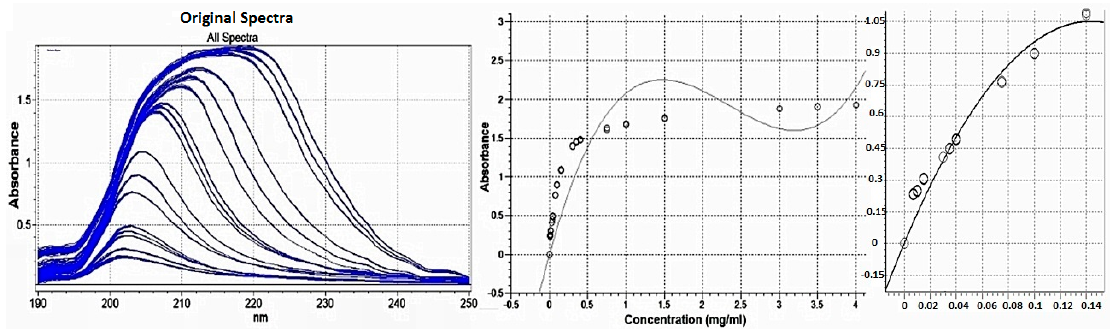
Figure 2. Multi-point calibration curve of clindamycin HCl at concentration range of 0.0075–4 mg/mL.